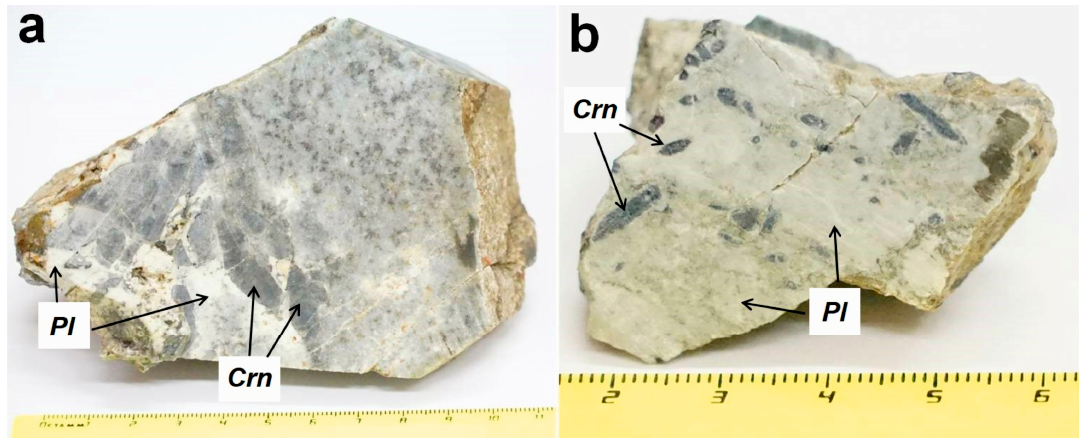
Figure 3. Photography of the samples used in this study with dipyramidal-prismatic corundum- sapphires (Crn) crystals elongated along the c axis and fine-grained plagioclase (Pl): ( a ) sample 2-K; and ( b ) sample 7-K.